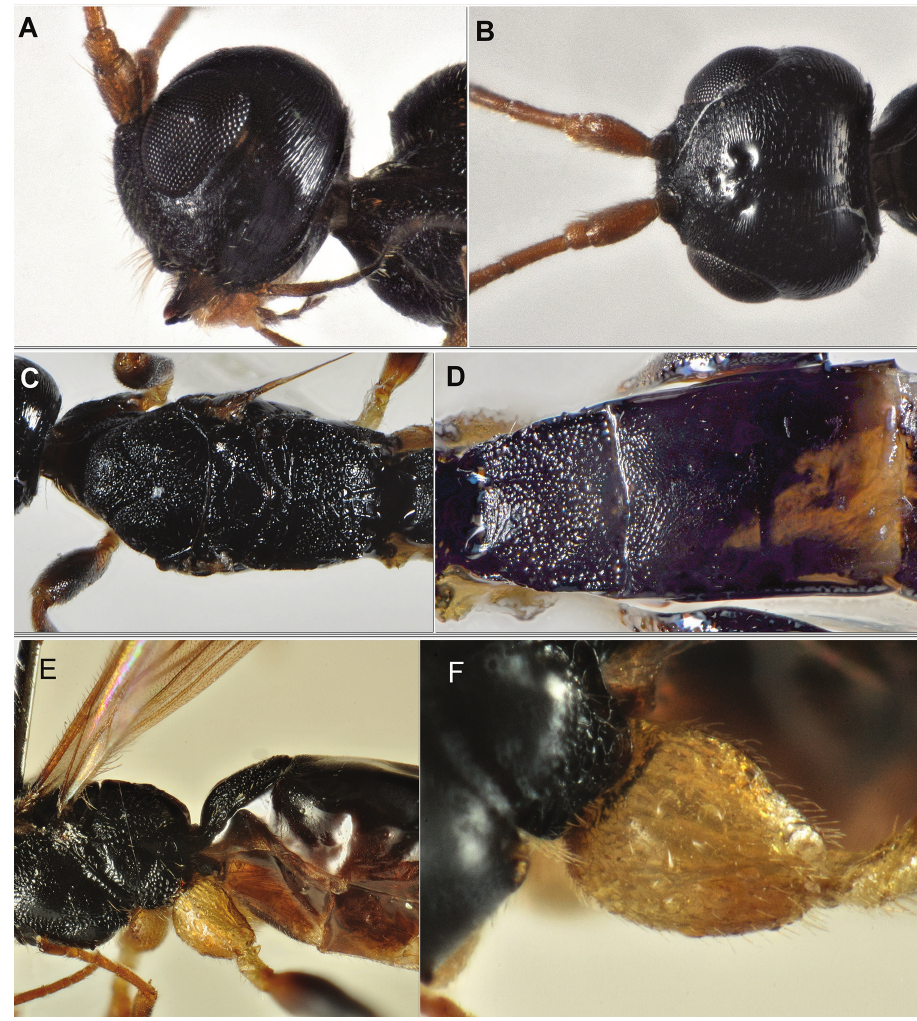
Figure 2. Rhoptrocentrus piceus Marshall: A head, lateral view B head, dorsal view C mesosoma, dorsal view D metasoma, first three segments, dorsal view E propodeum and base of metasoma, lateral view F hind coxa, lateral